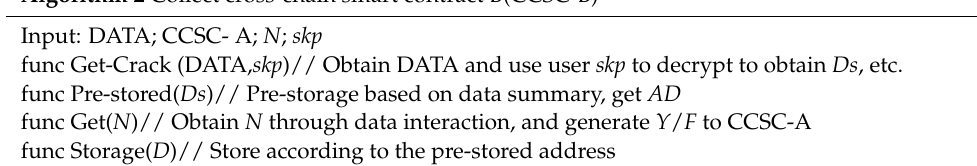
Algorithm 2 Collect cross-chain smart contract